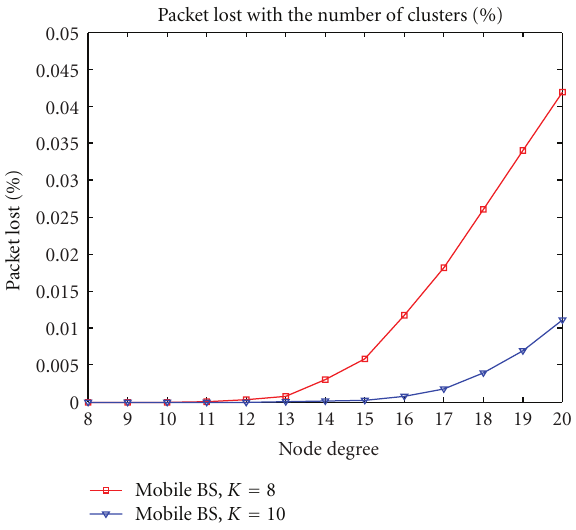
Figure 10: The percentage of network packet loss as the number of network sensor nodes is varied, for various numbers of